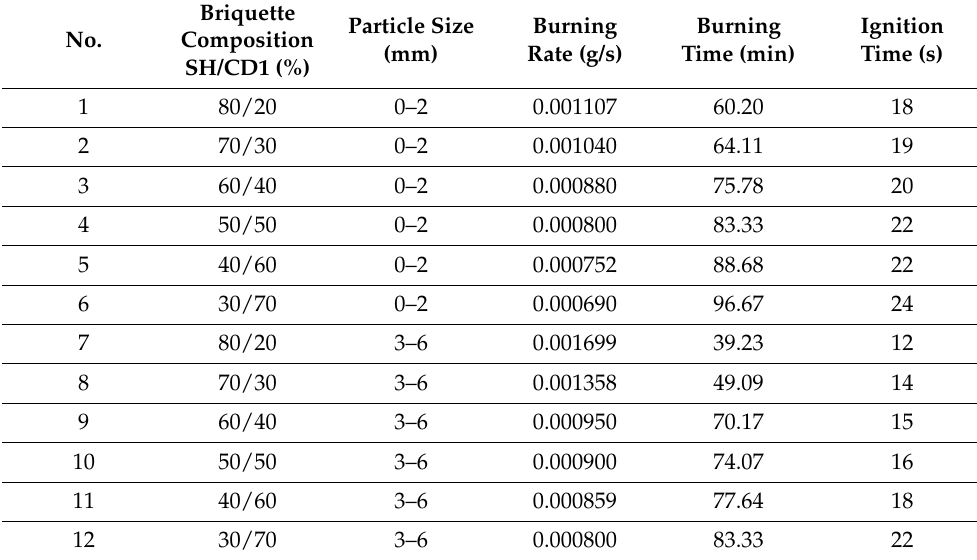
Table 7. The result of burning rate, burning rime and ignition (sunflower husk and coke dust).